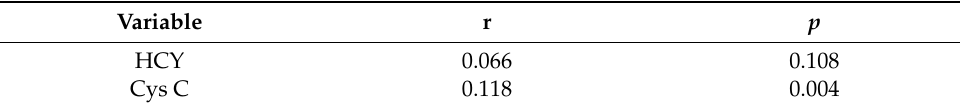
Table 7. Pearson correlation of UA RI and HCY with Cys C.